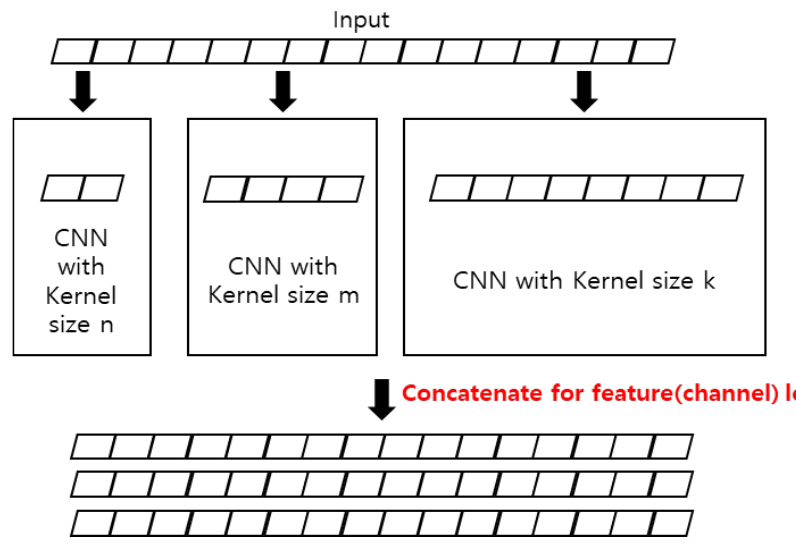
Figure 2. Feature extraction block using MCNN.